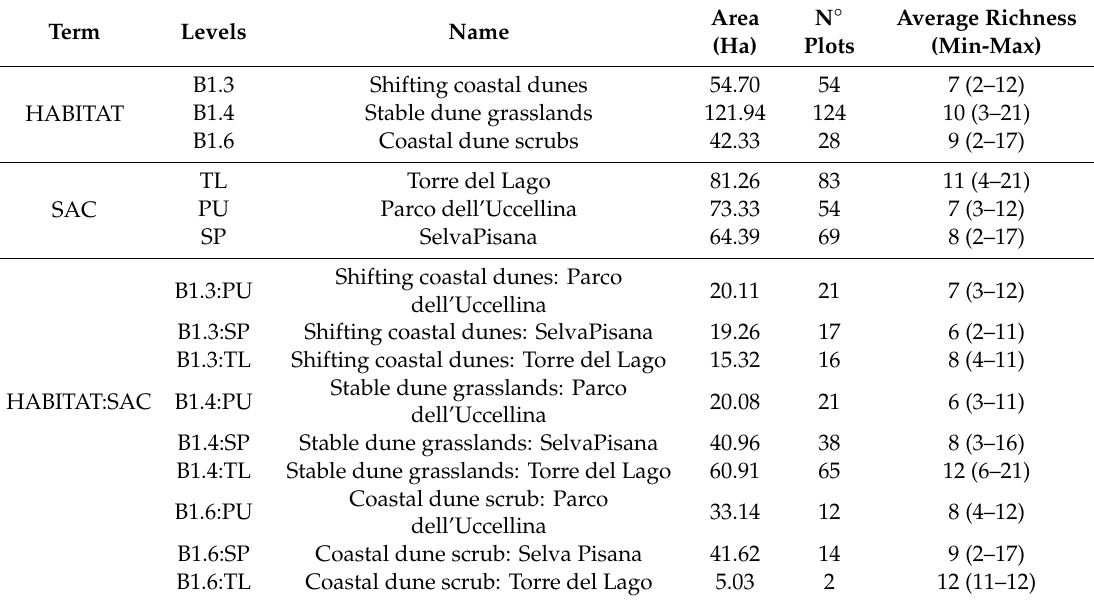
Table 2. Descriptive statistics of the study areas (area, number of plots and plant species richness) according to EUNIS habitat type, SAC and EUNIS type within